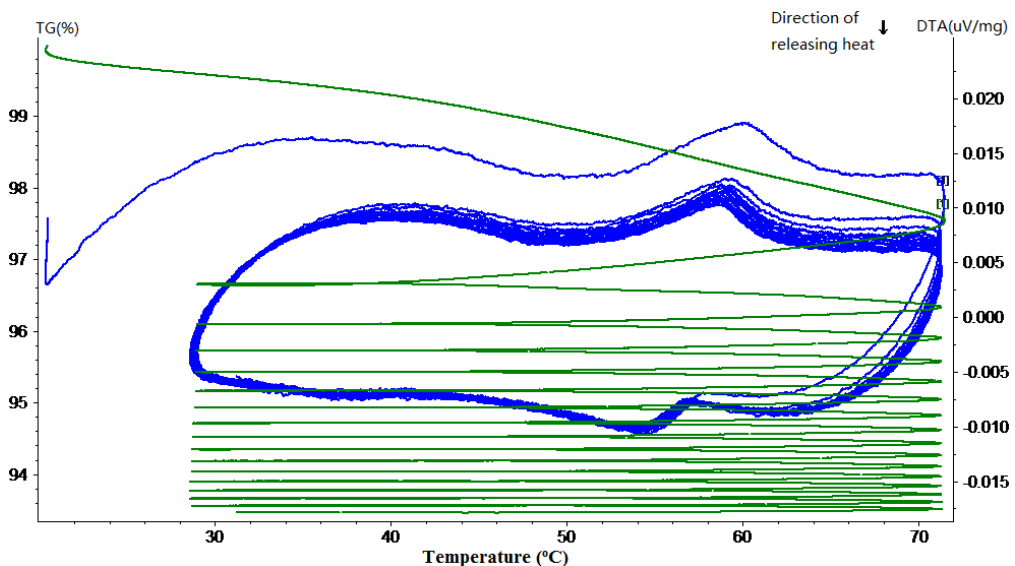
Figure 12. TG-DTA curve of the hardened cement paste specimen with 10%